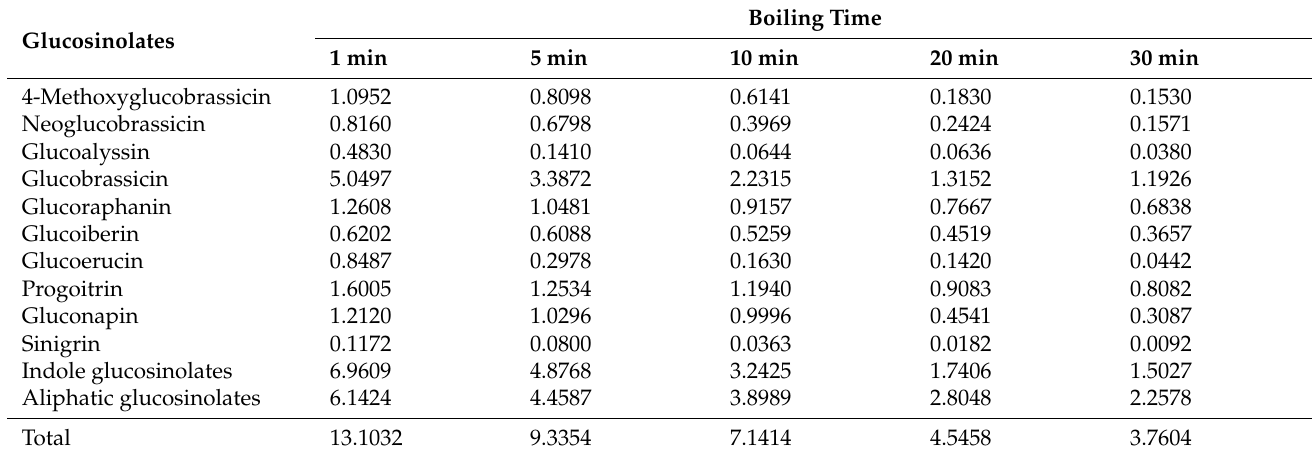
Table 4. Effects of boiling time on glucosinolate ( µ mol/g DW) in red